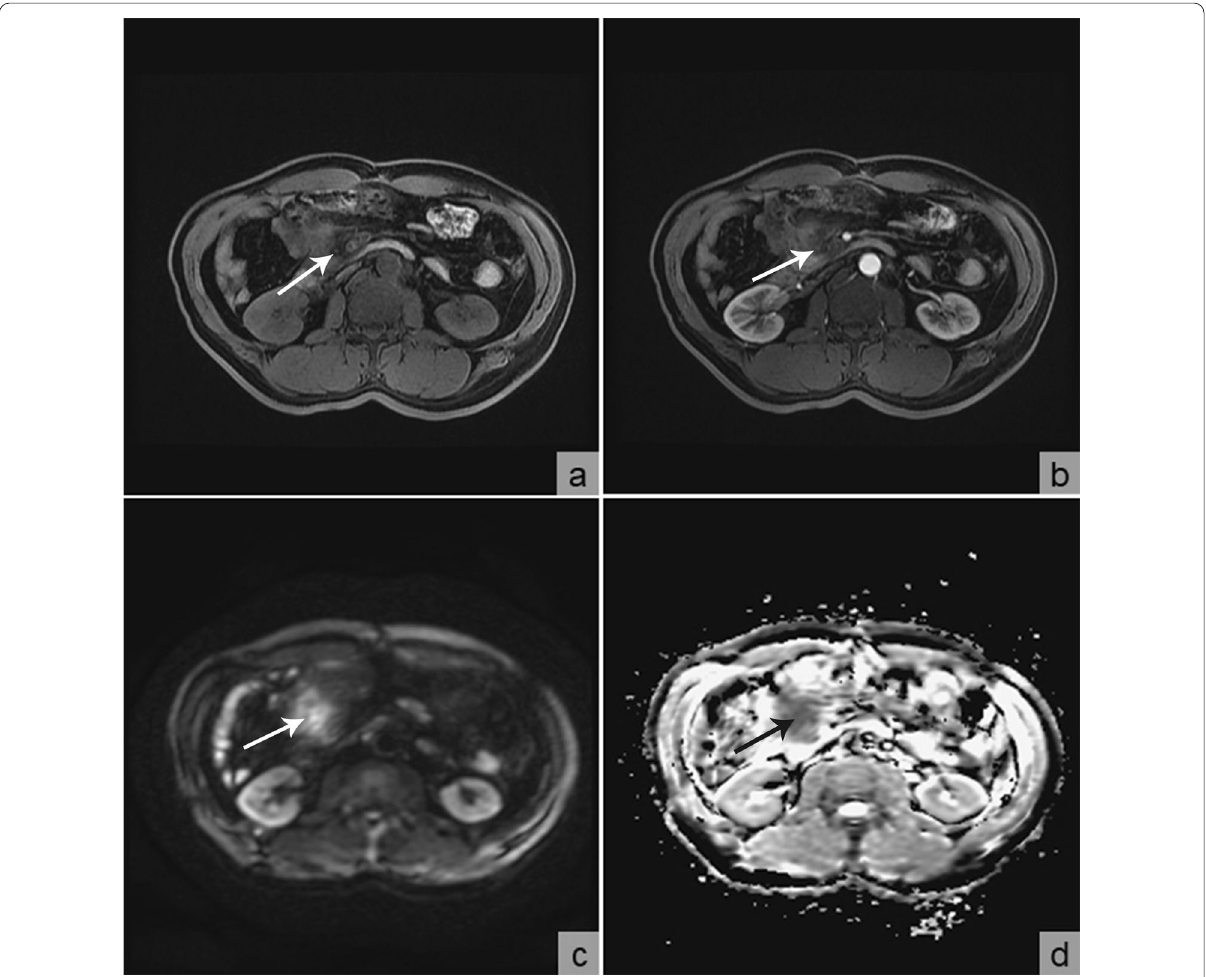
Fig. 3 Abdominal MRI revealed a heterogeneous infiltrative soft tissue lesion near the previous ileum–colon anastomosis exhibiting a hypointensity on precontrast T2‑weighted imaging (white arrow); b delayed and moderate enhancement on postcontrast T2‑weighted imaging (white arrow); c hyperintensity on diffusion‑weighted imaging (white arrow), and d water restriction on the ADC map (black